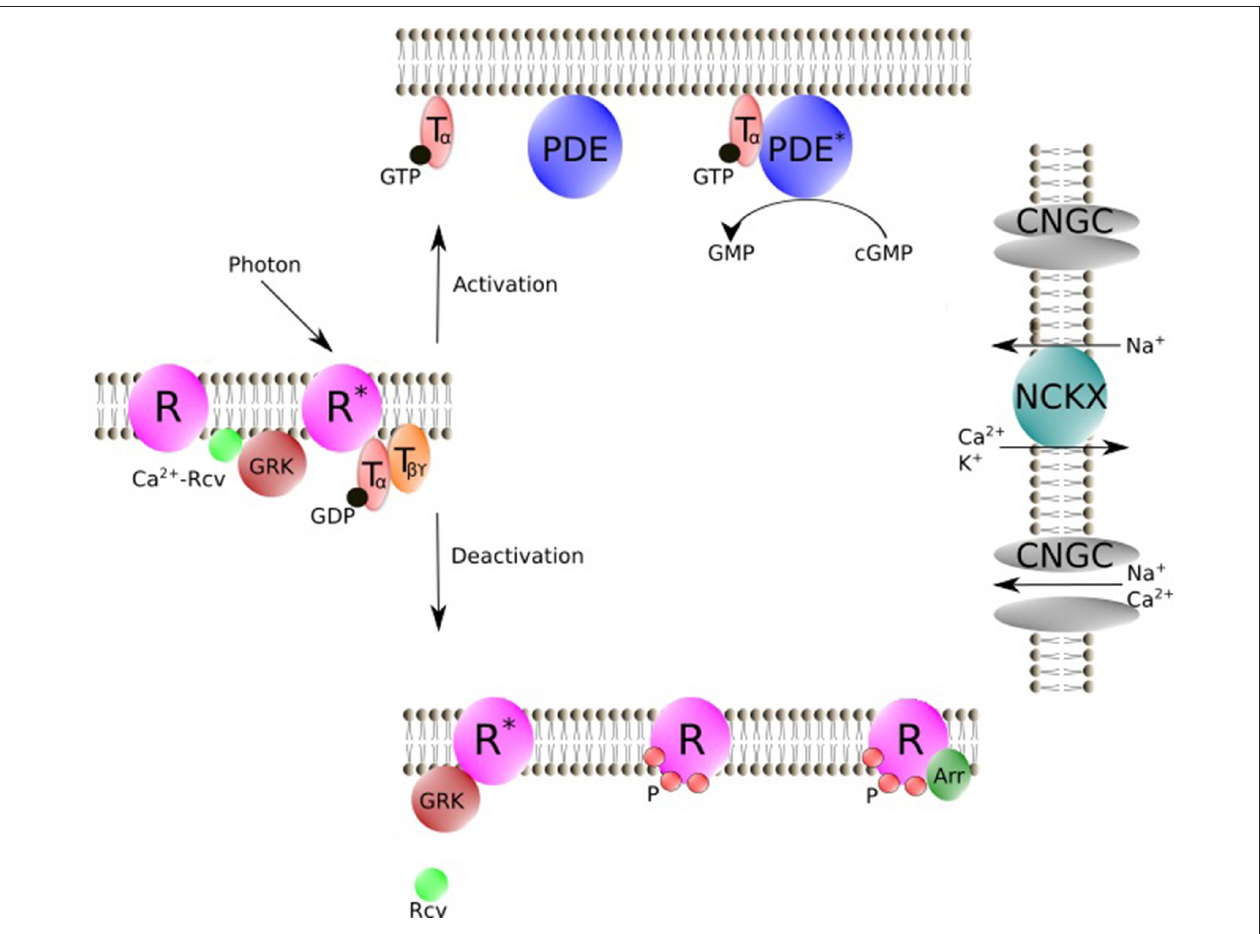
FIGURE 2 | Schematic representation of vertebrate phototransduction cascade and the deactivation process for R ∗ regulated by Rcv. Photon absorption activates R. R ∗ then triggers the exchange of GTP for GDP on the T α . T α -GTP binds to cyclic nucleotide PDE. Stimulated PDE hydrolyzes free cyclic guanosine monophosphate (cGMP). In darkness, CNGC allows an influx of Na + and Ca 2+ , while during illumination CNGC is shut off by cGMP decrease. NCKX is not affected by light, which results in a light-induced [Ca 2+ ] i decline. Rcv modulates phosphorylation of R ∗ via GRK in a Ca 2+ dependent manner. Phosphorylated R then is fully deactivated by binding of Arr. R, Visual pigment (inactive); R ∗ , Light-activated visual pigment; T α , Transducin α subunit; T βΥ , Transducin β and Υ subunits; PDE, Phosphodiesterase (inactive); PDE ∗ , PDE-Transducin complex; NCKX, Na + /Ca 2+ , K + exchanger, Arr, Arrestin; GRK, G protein-coupled receptor kinase; Rcv, Recoverin; CNGC, cyclic nucleotide–gated ion channels; P, Phosphorylation; Figure was drawn using Inkscape. Inkscape